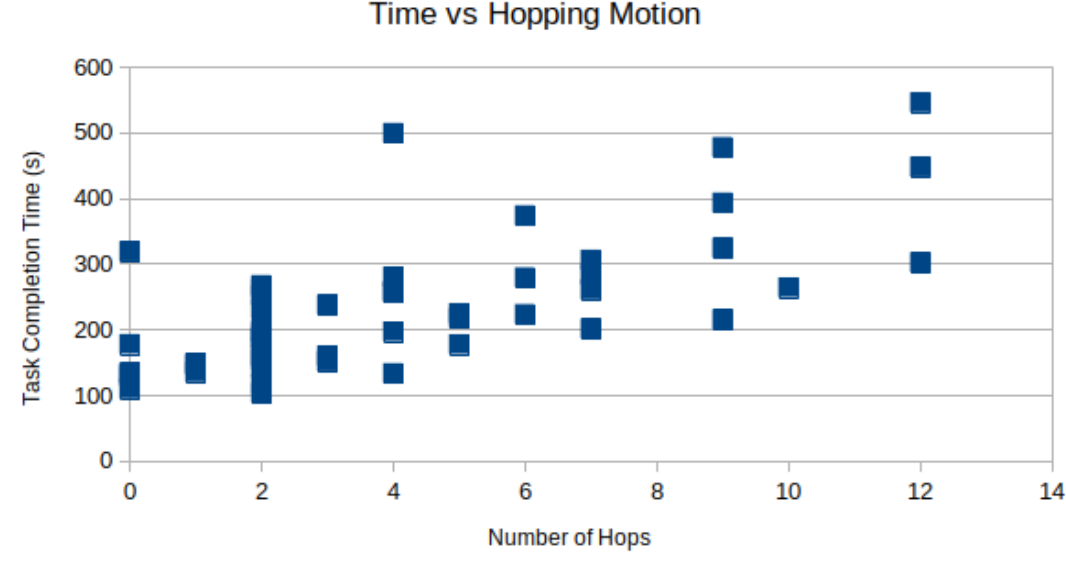
Figure 8. Effect of Camera Hopping: In this chart, we can see that usage of camera hopping has a moderate positive correlation with time-to-complete. (R =